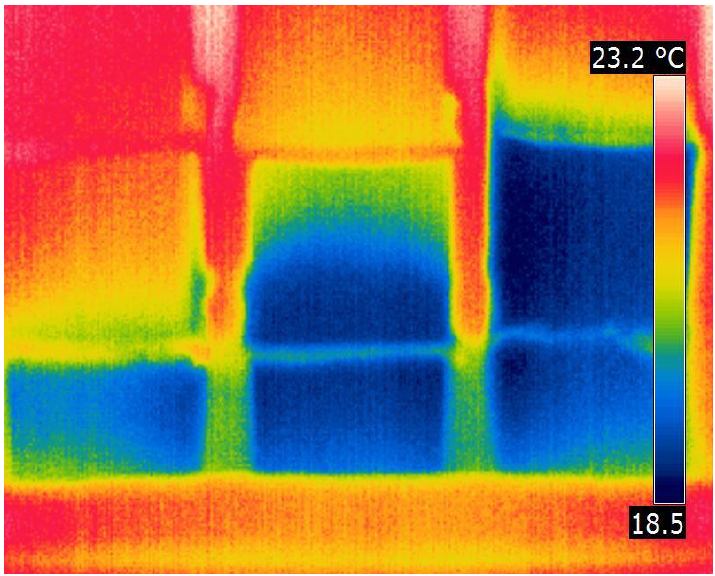
Figure A6. Thermographic report dated November 9, 2018, for Carparo (C.), Lecce stone (L.S.), and Tuff (T.).